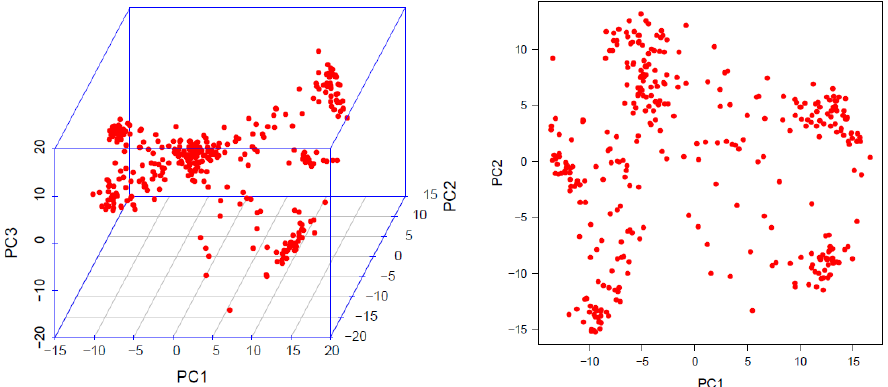
Figure 3. 3D and 2D distribution of the maize lines composing the association mapping panel according to the first three principal components (PC1, PC2, and PC3) generated from the 3124 LD-pruned markers.